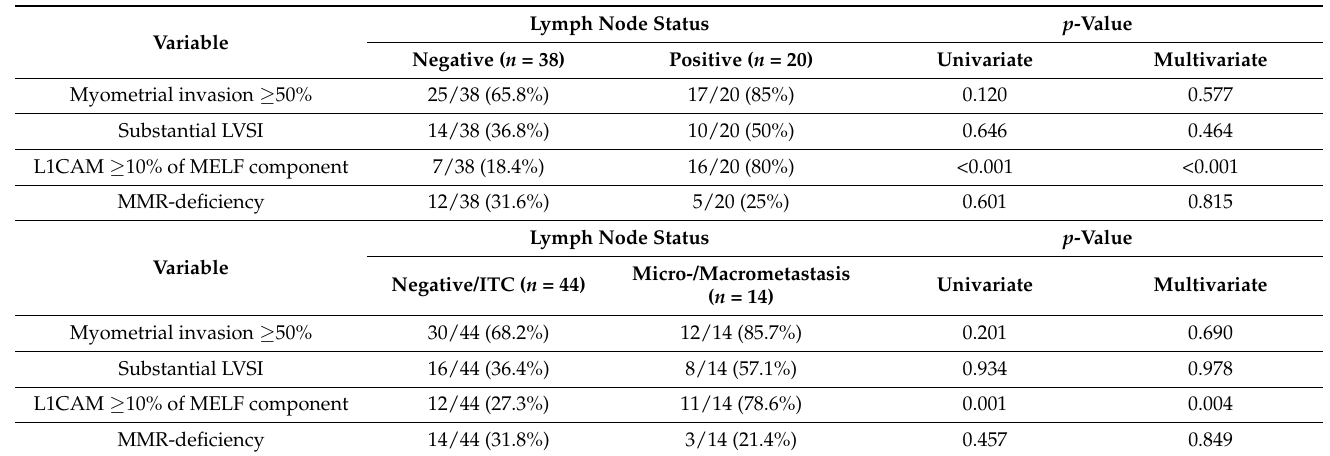
Figure 1. Microcystic, elongated and fragmented (MELF) pattern of invasion in endometrial carci- noma. ( A ) Low-grade endometrioid carcinoma with a MELF pattern on the invasion front on the left (hematoxylin-eosin; magnification ×40). ( B ) L1CAM overexpression in the MELF component (L1CAM immunohistochemistry; magnification ×40); please note that L1CAM positivity makes MELF glands more evident compared to the routine hematoxylin-eosin stain of the panel ( A ). ( C ) Detail of MELF glands at the invasion front of a low-grade endometrioid carcinoma (hematoxylin- eosin; magnification ×200). ( D ) Detail of MELF glands lacking L1CAM expression (L1CAM im- munohistochemistry; magnification ×200). Table 2. Summary of histopathological and immunohistochemical features with regard to lymph node status and results of univariate and multivariate logistic regression.